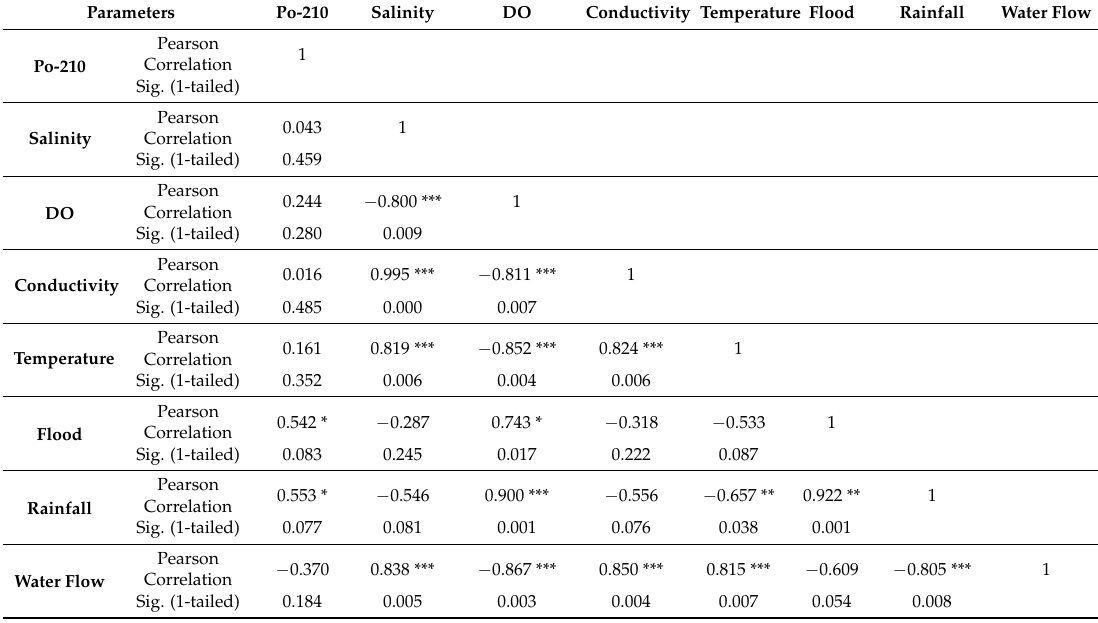
Figure 3. Geological map of Langat River Basin, Malaysia [4]. Table 5. Correlation of water quality and environmental parameters in Langat